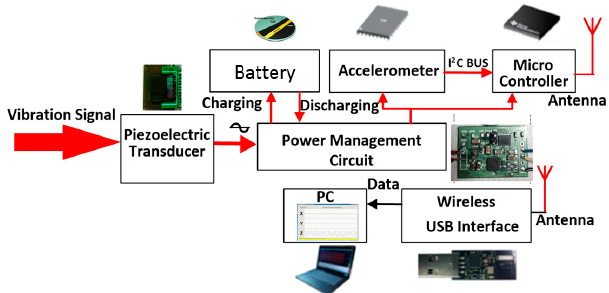
Figure 2. The proposed self-powered engine health monitoring system.